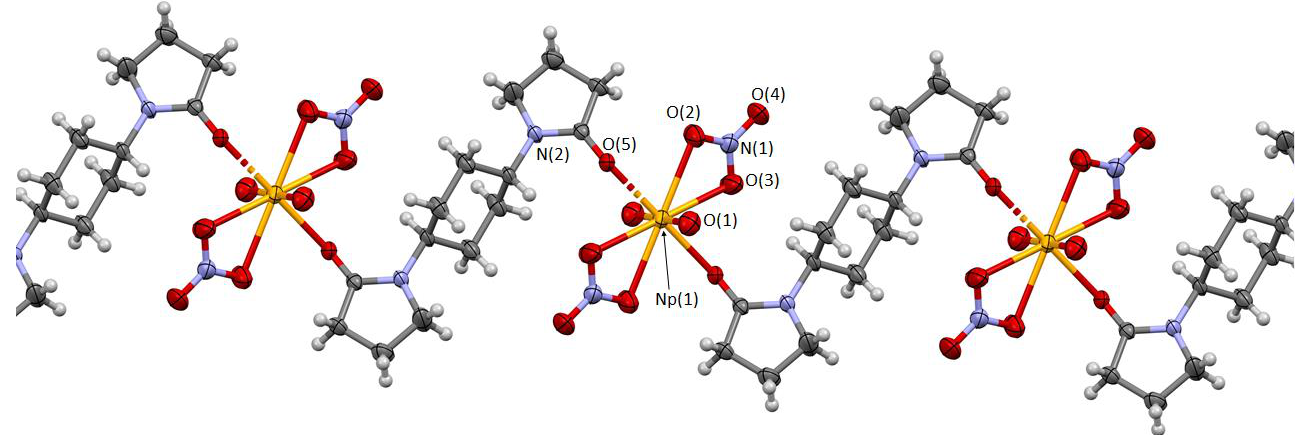
3 of 11 Figure 2. Photomicrograph of deposited crystals of [NpO 2 (NO 3 ) 2 ( L1 )] n . Molecular and crystal structures of this compound were determined by single crystal X-ray analysis at 293 K. As a result, this compound shown in Figure 3 was found to consist of NpO 2 (NO 3 ) 2 units connected by L1 linker molecules to form an infinite one-dimensional (1D) coordination polymer, [NpO 2 (NO 3 ) 2 ( L1 )] n , which should be formed through the fol- lowing reaction in the HNO 3 solution. n NpO 22+ + 2 n NO 3 − + n L1 = [NpO 2 (NO 3 ) 2 ( L1 )] n (cr),